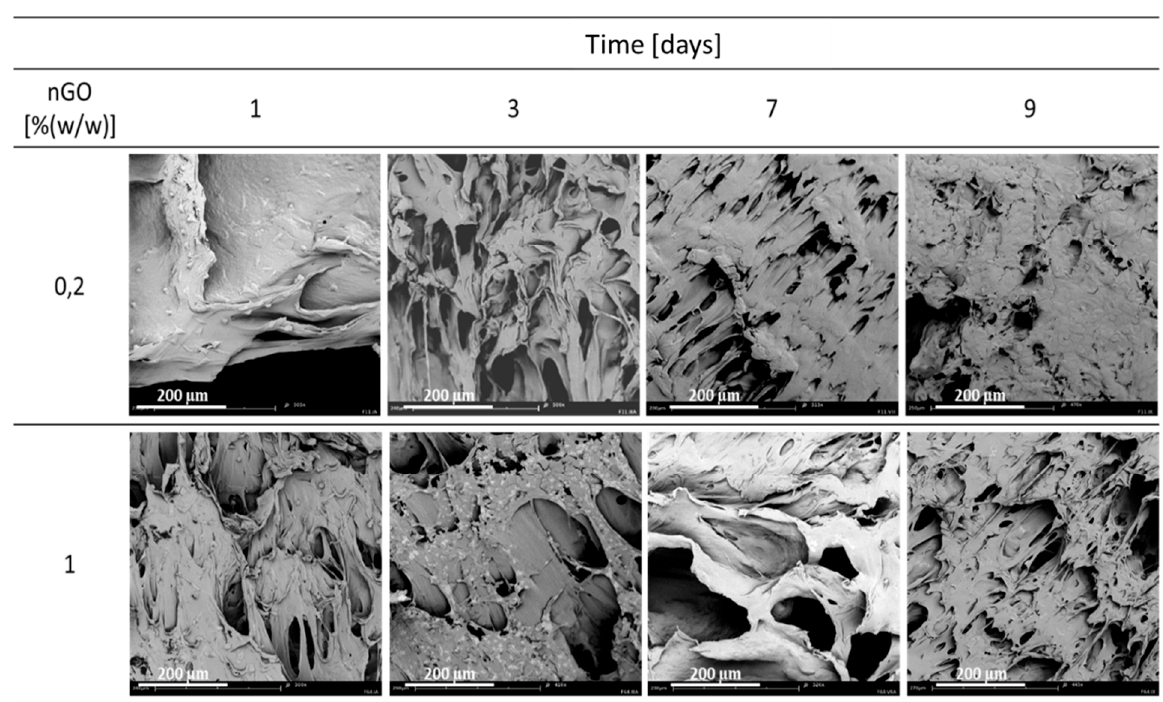
Figure 7. Cell culture on composite materials containing 0.2 and 1% ( w/w ) nGO produced at the conditions of T sat = 70 °C, P sat = 18 MPa, t sat = 1 h on 1, 3, 7 and 9 days.